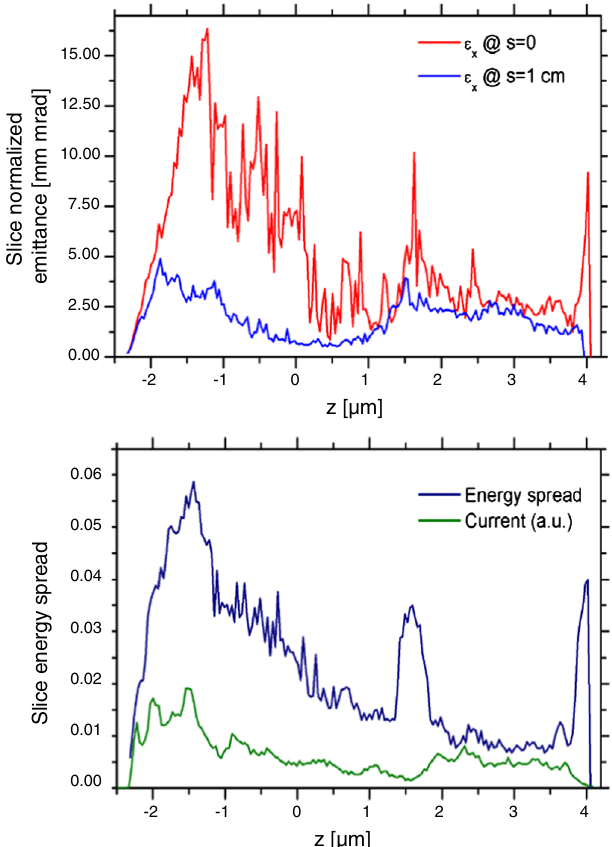
FIG. 3. Comparison of slice normalized emittance at the inter- action point and after a 1 cm drift space (top) and slice energy spread (bottom). The number of slices in the longitudinal plane is